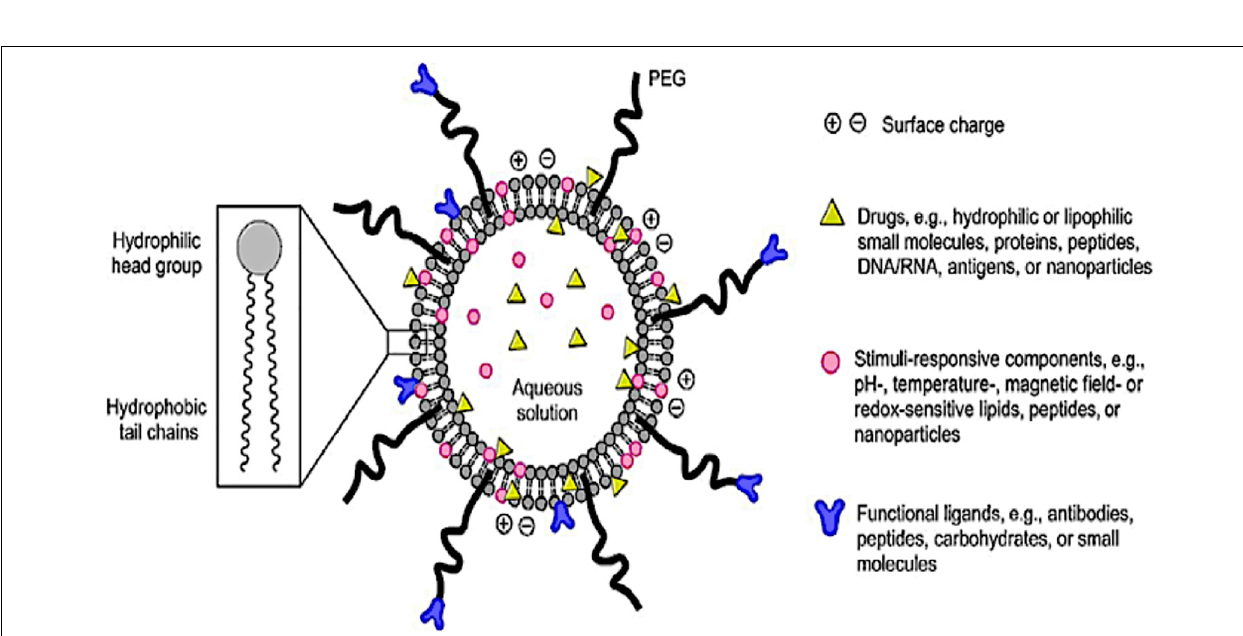
FIGURE 2 | A schematic diagram of a smart lipid-based nanoparticles system as a nano-enabled drug delivery platform (reprinted with permission from Li and Takeoka, 2018).